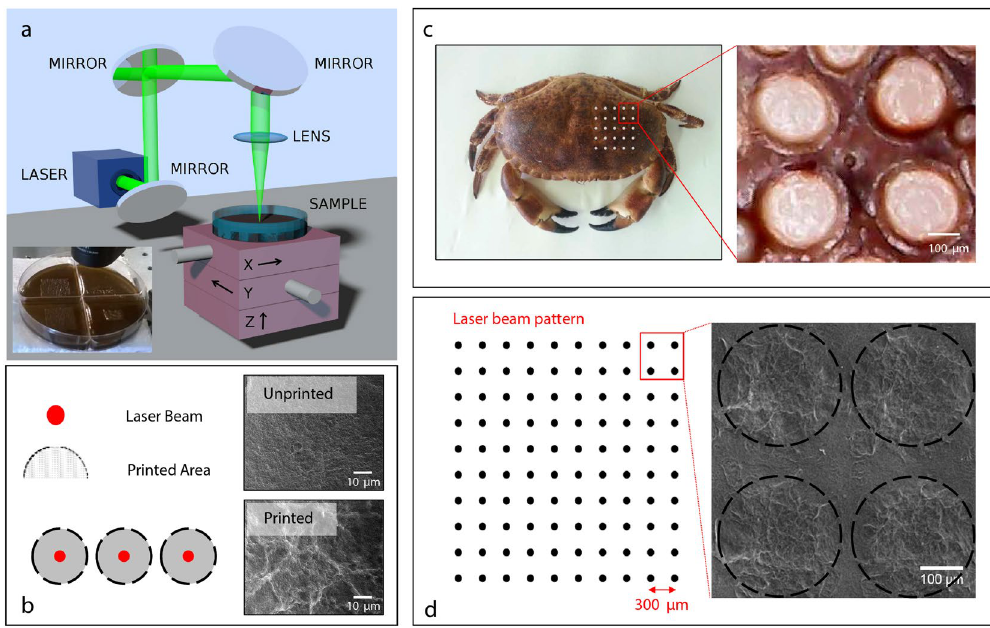
Figure 1. Pattern realization. ( a ) Experimental setup for the laser printing of the surface of the Agar substrates. Inset: Patterned GO-agar substrate by focusing a 5 mJ laser pulse. ( b ) On the left, sketch of the laser pulse action as occurs on the GO-based substrate: the red bullets represent the point interested by the laser pulse, the gray area is subject to the cavitation induced by the thermal expansion of the GO-Agar. The panels on the right show SEM images of the unprinted (top) and printed (bottom) area of the substrate (Figure S1 shows further details). ( c ) Cancer Pagurus (left) and detail of the carapace pattern (right). ( d ) Sketch of the geometry of the optically realized patterns (left) and SEM images